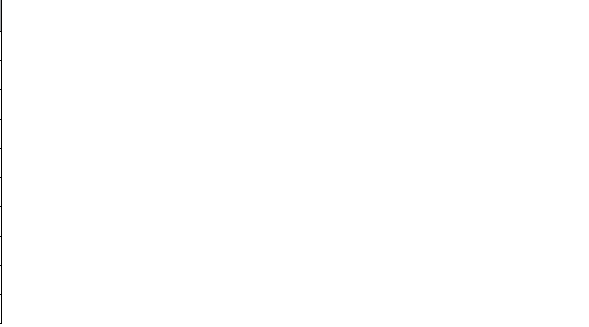
Table 3. The relative changes in expression (Fold change) of miRNAs among HbS homozygous patient vs control and HbS homozygous on HU after both 3 and 6 months’ time points (denoted as SCA/HU) vs HbS homozygous patients at baseline. *Significant at p < 0.05, **Significant at p ≤ 0.01.